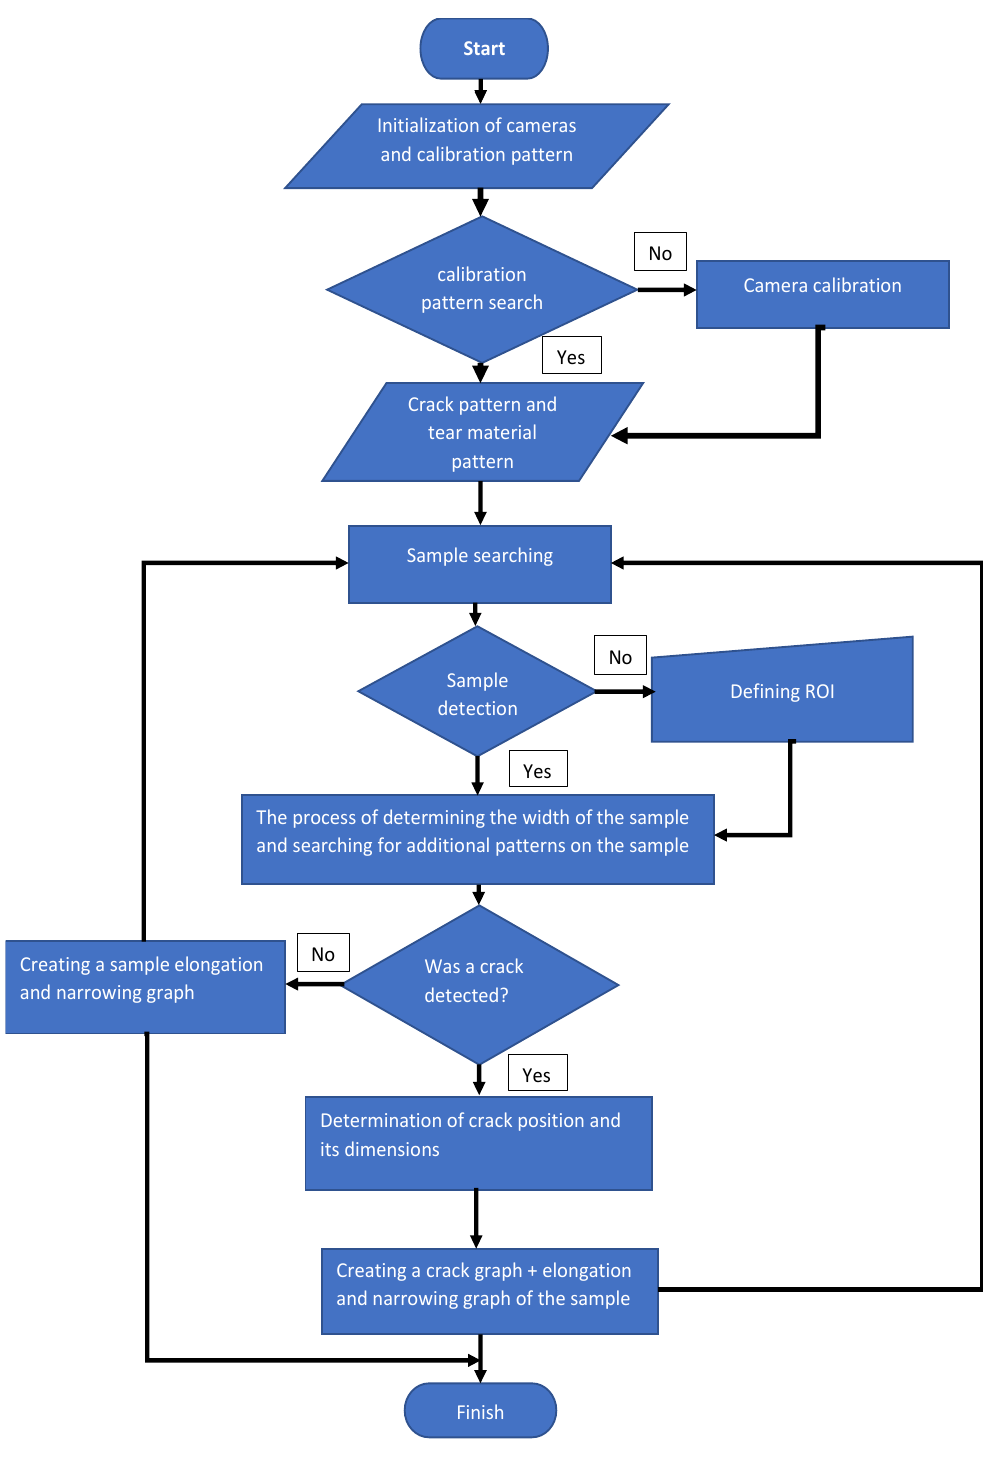
Figure 4. Flowchart of our algorithm.